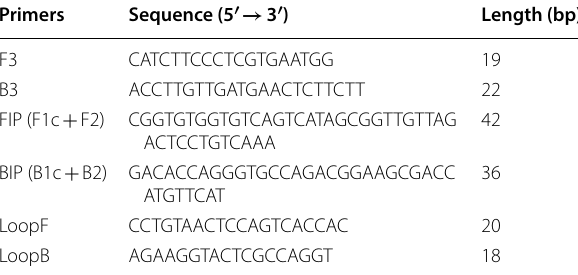
Table 2 The primer NS5-2 used for detection of Zika virus